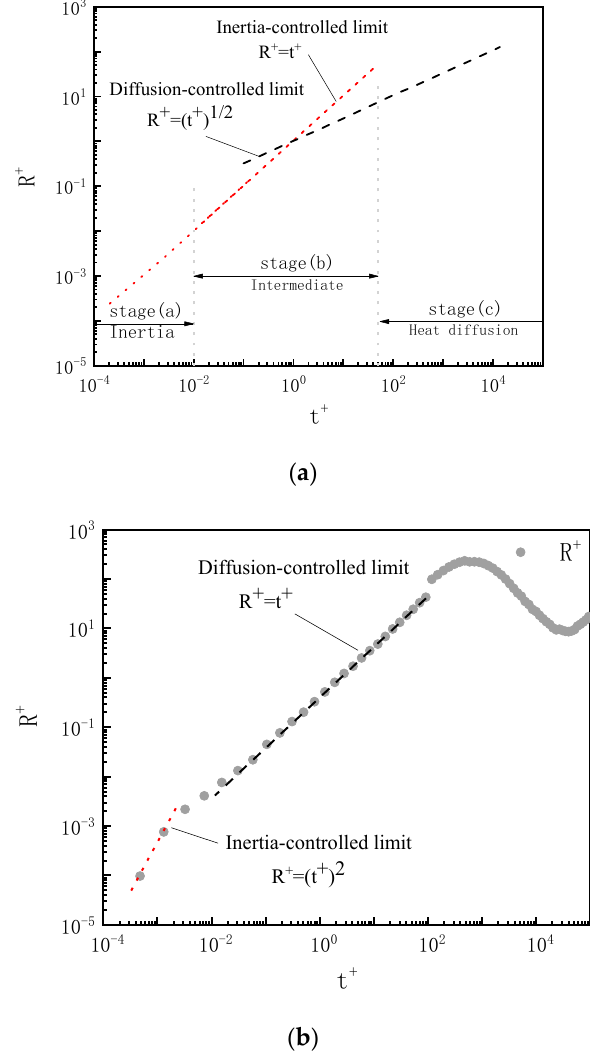
Figure 3. ( a ) Change of radius with time in stages of purely inertial growth and thermally controlled growth from Lee and Merte [17]; ( b ) numerical results of the smoothed particle hydrodynamics (SPH) of the radius–time curve at different stages of bubble growth.